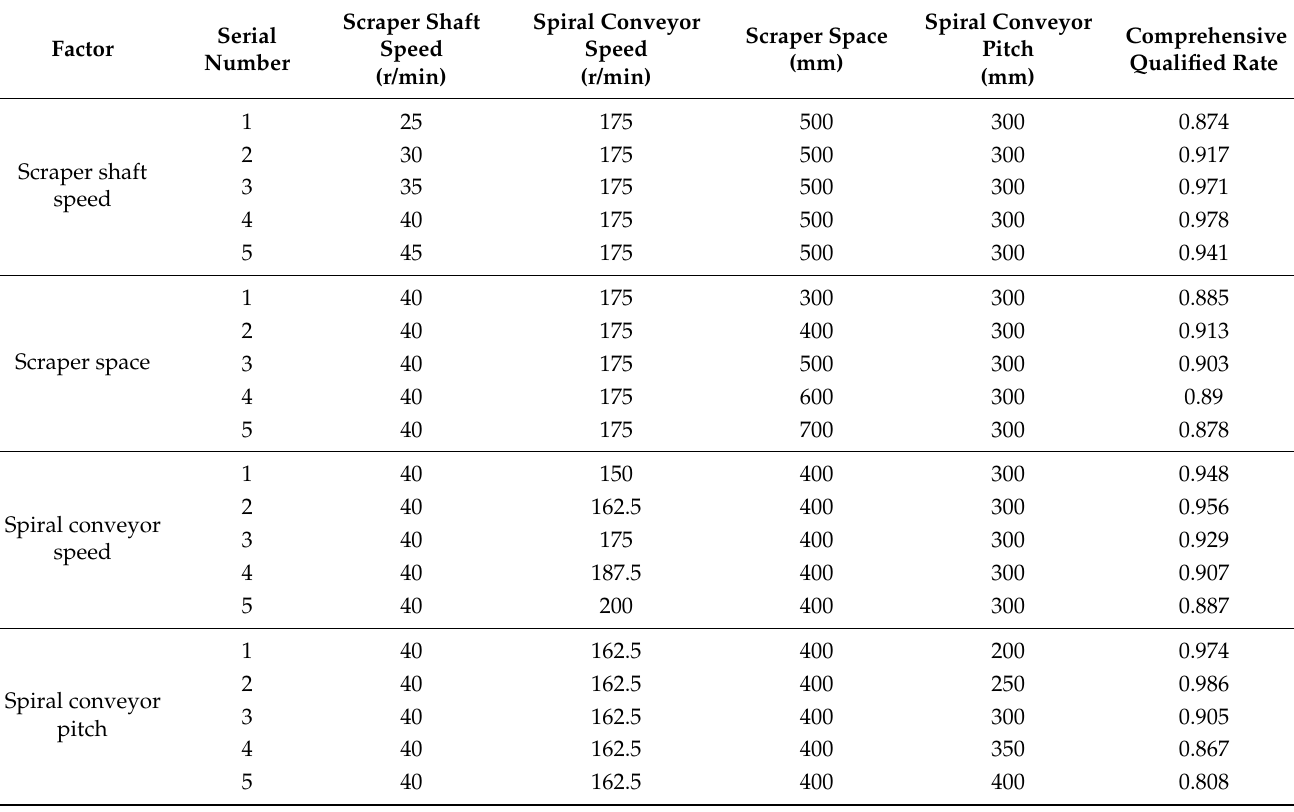
Table 4. Design and result of single-factor